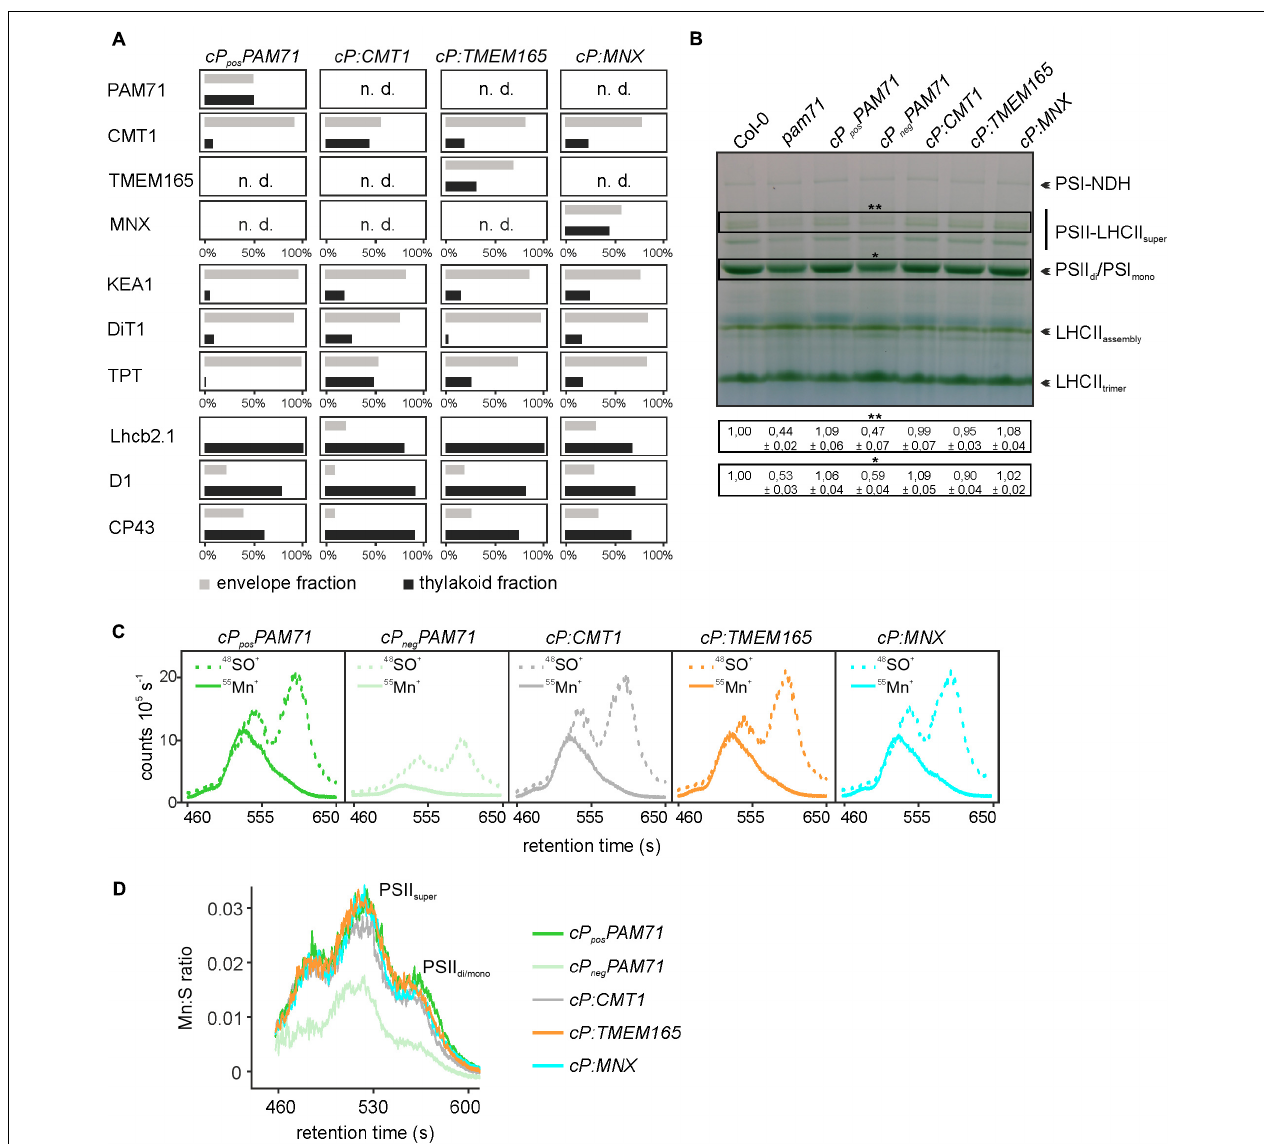
FIGURE 5 | Proteomic and ICP-MS analysis of individual transgenic lines with pam71 genetic background. (A) PAM71, CMT1, TMEM165, MNX and marker proteins of envelope and thylakoid enriched fractions of the indicated plant lines. The K + efflux antiporter 1 (KEA1), dicarboxylate transporter 1 (DiT1) and triosephosphate/phosphate translocator (TPT) were used as envelope marker proteins, and chlorophyll a-b binding protein 2.1 (Lhcb2.1), photosystem II protein D1 (D1) and photosystem II CP43 reaction center protein (CP43) served as thylakoid markers. The proteomic analysis is based on three independent experiments and data depicted are derived from Experiment 2 ( Supplementary Tables 3–6 ). n.d., not detected. (B) Accumulation of thylakoid photosynthetic complexes in transgenic lines in comparison to levels in Col-0 and pam71 . Thylakoid membrane samples (equivalent to 18 µ g of protein) were solubilized with 1% (w/v) β -dodecyl-maltoside, and protein complexes were fractionated by Blue-Native gel electrophoreses. NDH, NADH dehydrogenase-like; PSI, photosystem I; PSII, photosystem II; LHCII, light-harvesting complex of photosystem II. The different assembly states are indicated. Quantification of the indicated complexes (**PSII-LHCII supercomplexes and *PSII dimer/PSI monomer complexes) is based on intensity levels in Col-0 (=1,00). Mean values ± SD ( n = 3) are shown. (C) Size-exclusion chromatograms depicting the relative intensities of the non-oxide ion 55 Mn + and the oxide ion 48 SO + in the transgenic lines. Thylakoid membranes (equivalent to 50 µ g of protein) were solubilized with 1% (w/v) α -dodecyl-maltoside, and protein complexes were fractionated on a size-exclusion column. Analysis was performed with two independent experiments. (D) Quantification of the Mn:S ratios in the transgenic lines. Mn:S ratios are shown for the fractionated photosynthetic complexes from the samples analyzed in panel (C) . PSII, Photosystem II; different assembly states are indicated. The data are based on two independent experiments.